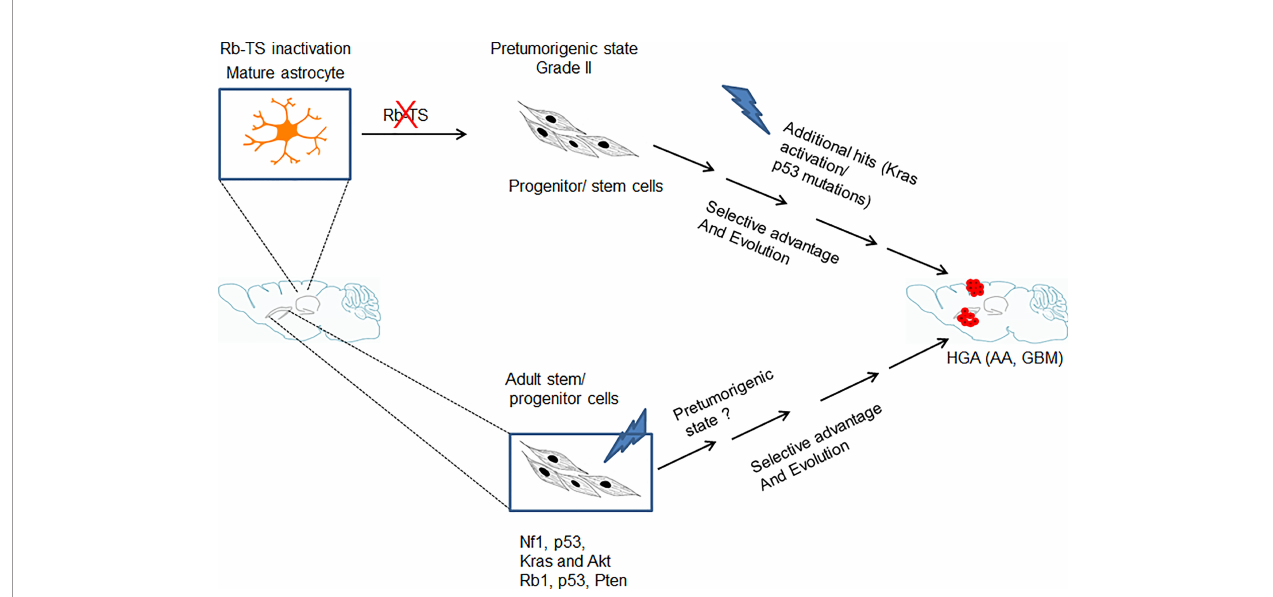
FIGURE 6 | Model showing genetic alteration and cell type speci fi c pathways for GBM development. Transition of mature astrocytes by Rb-TS inactivated and generation of pretumorigenic state that after accumulation of additional spontaneous mutations, along with selective pressure and evolution initiates